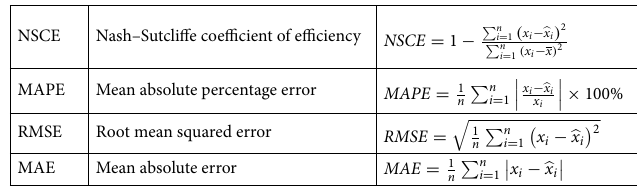
Table 2. The definition of NSCE, MAPE, RMSE, and MAE.